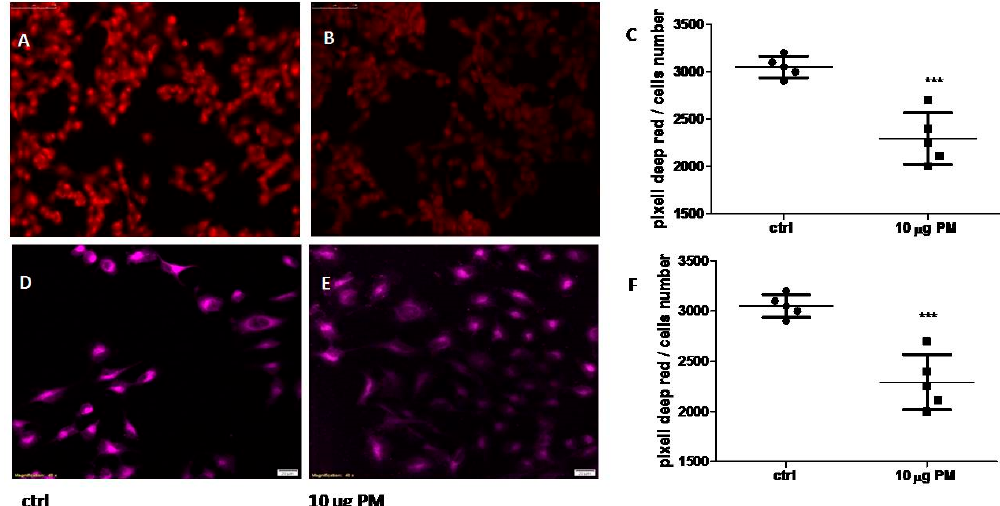
Figure 3. Mitochondrial membrane potential and intracellular reactive oxygen species (ROS) upon PM. Representative images of mitochondrial membrane potential (MMP) stained in keratinocytes cultured without ( A ) and on 10 µ g of PM ( B ) for 24 h. Scale bars: 20 µ m ( C ). Quantification of the average cell area pixel for red staining keratinocytes. Data in C represent mean ± sd of n = 3 independent experiments (*** P = 0.0002). Representative images of intROS stained in keratinocytes cultured without ( D ) and on 10 µ g of PM ( E ) for 24 h. Scale bars: 20 µ m. ( F ) Quantification of average cell area pixel for deep red staining keratinocytes. Data in F represent mean ± sd of n = 3 independent experiments (*** P = 0.0002 ).